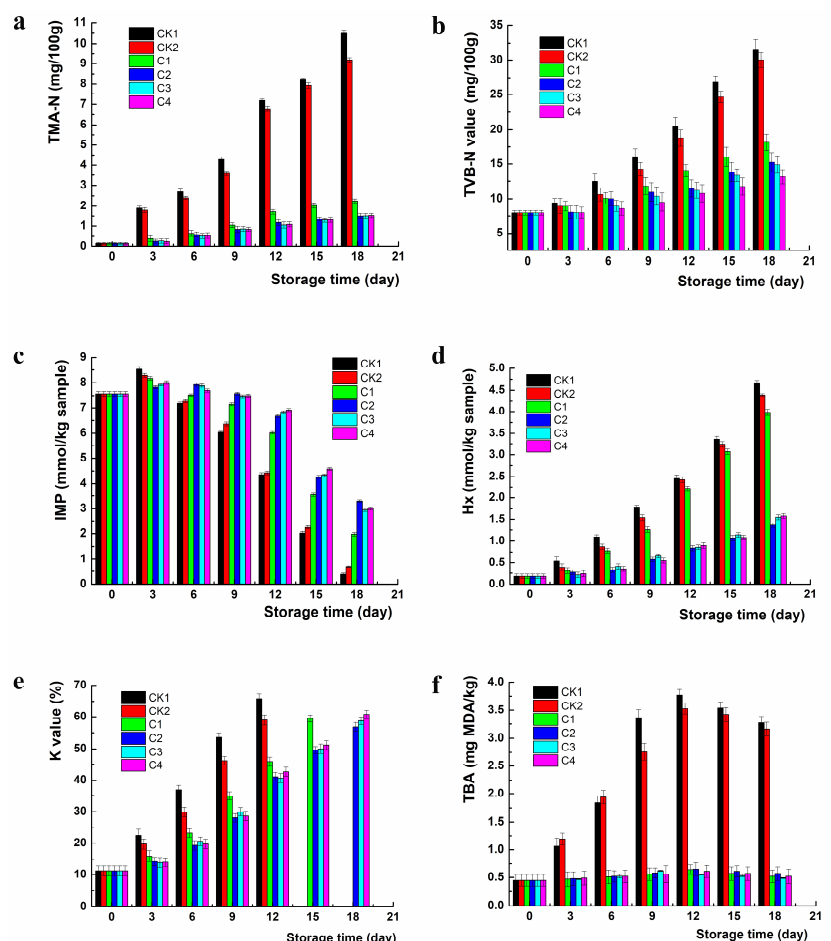
Figure 2. Changes in trimethylamine (TMA, a ), total volatile basic nitrogen values (TVB-N, b ), inosine 5′-monophosphate (IMP, c ), hypoxanthine (Hx, d ), K value ( e ), and Thiobarbituric acid (TBA, f ) of half-smooth tongue sole fillets during refrigerated storage (CK1: Chitosan coating without rosmarinic acid or ε-PL; CK2: Chitosan coating with 30 mg/kg rosmarinic acid; C1/C2/C3/C4: Chitosan coating with 30 mg/kg rosmarinic acid and 0.05%/0.10%/0.15%/0.20% ε-PL).